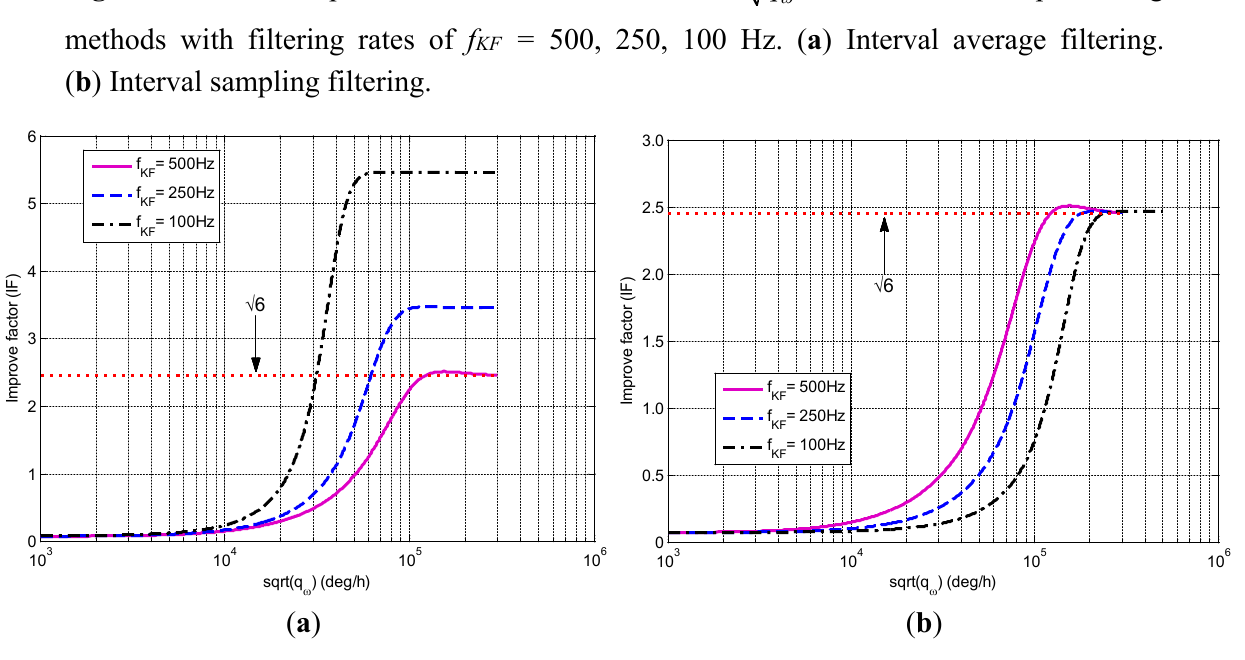
q for two different processing ω